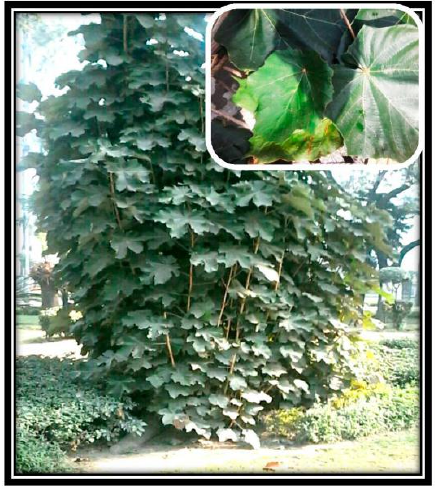
Figure 1. Pterospermum acerifolium tree.